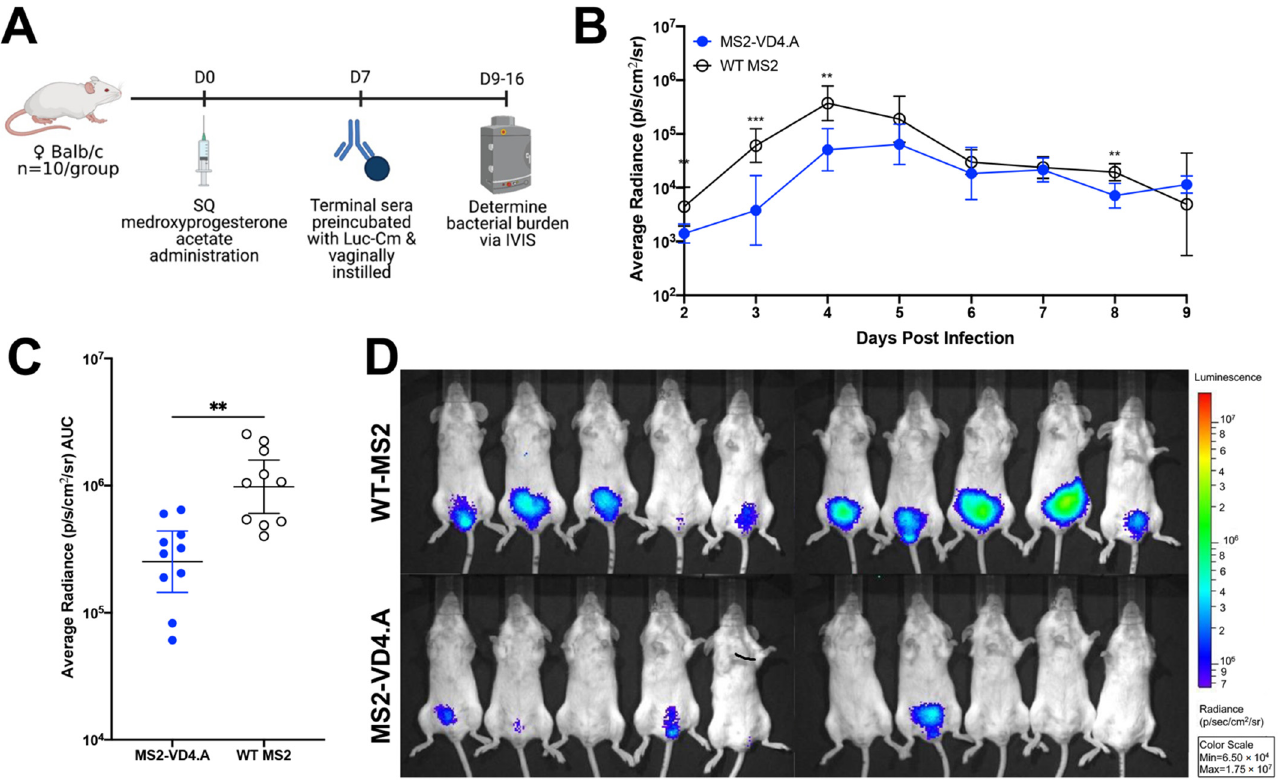
Figure 8. Protection from vaginal Chlamydia infection can be mediated by antibodies. ( A ) Study design for in vivo neutralization. Naïve female Balb/c mice ( n = 10/group) were vaginally challenged with 2 × 10 4 IFU of Luc-Cm that was preincubated with terminal immune sera from mice vaccinated with either MS2-VD4.A or WT MS2. Bacterial burden was determined on days 2 through 9 post infection. ( B ) Average radiance (p/s/cm 2 /sr) measured for mice receiving Luc-Cm preincubated with either MS2-VD4.A or WT MS2 immune sera on days 2 through 9 post infection. ( C ) Area under the curve (AUC) measured for average radiance on days 2 through 9 post infection. ( D ) IVIS image for mice receiving Luc-Cm preincubated with either WT MS2 immune sera (top) or MS2-VD4.A immune sera (bottom) on day 3 post infection, with luminescence visualized, shown as a representative image of those collected each day. Statistical analysis was performed utilizing the non- parametric Mann–Whitney t -test. Quantitative data represent the geometric mean ± SEM. ** p < 0.01, *** p <